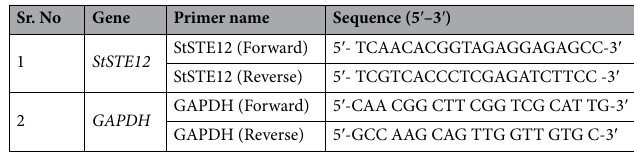
Table 3. Detail of genes and primers used for gene expression